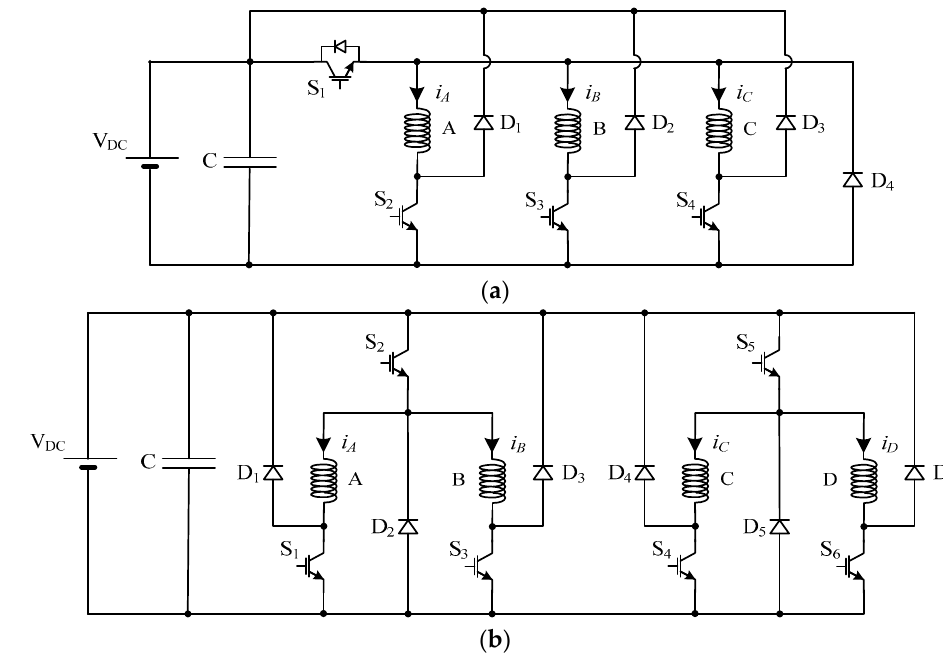
Figure 4. Shared switch topologies ( a ) per three phases, ( b ) per two phases.